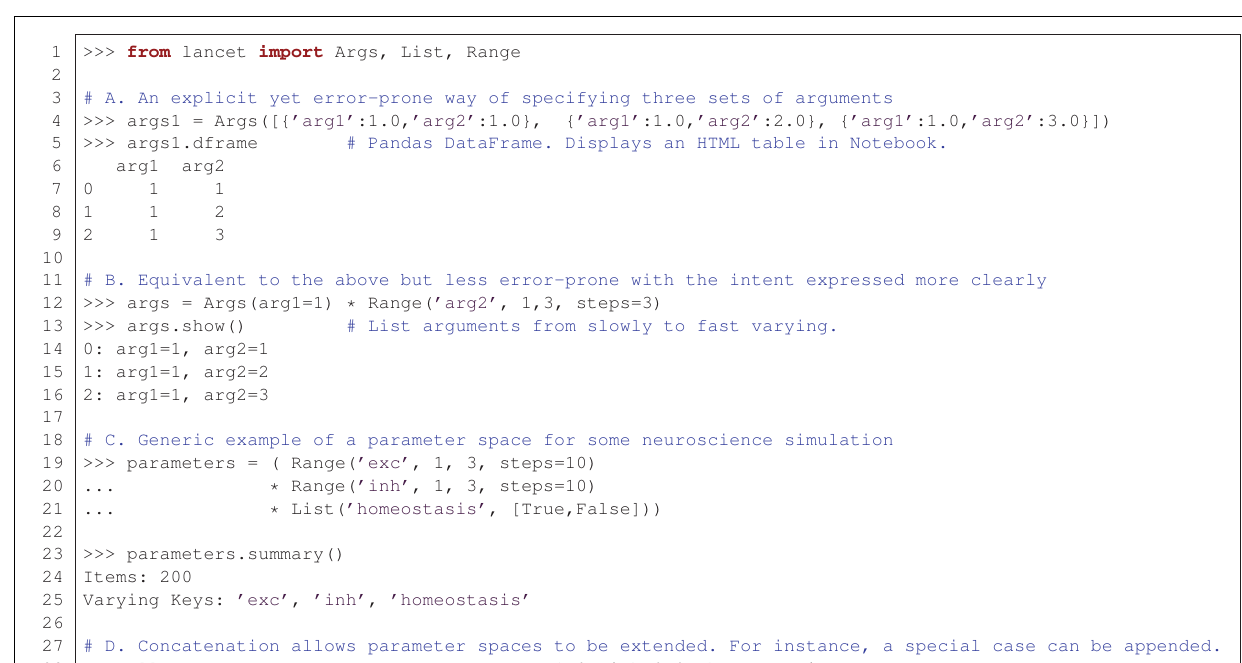
FIGURE 2 | Arguments express parameter spaces succinctly and declaratively. (A) Example illustrating the most basic, most explicit use of the Args class to specify three sets of sequential arguments. (B) A more succinct and less error-prone way of specifying the same arguments. (C) An example expressing a parameter space for use with a hypothetical